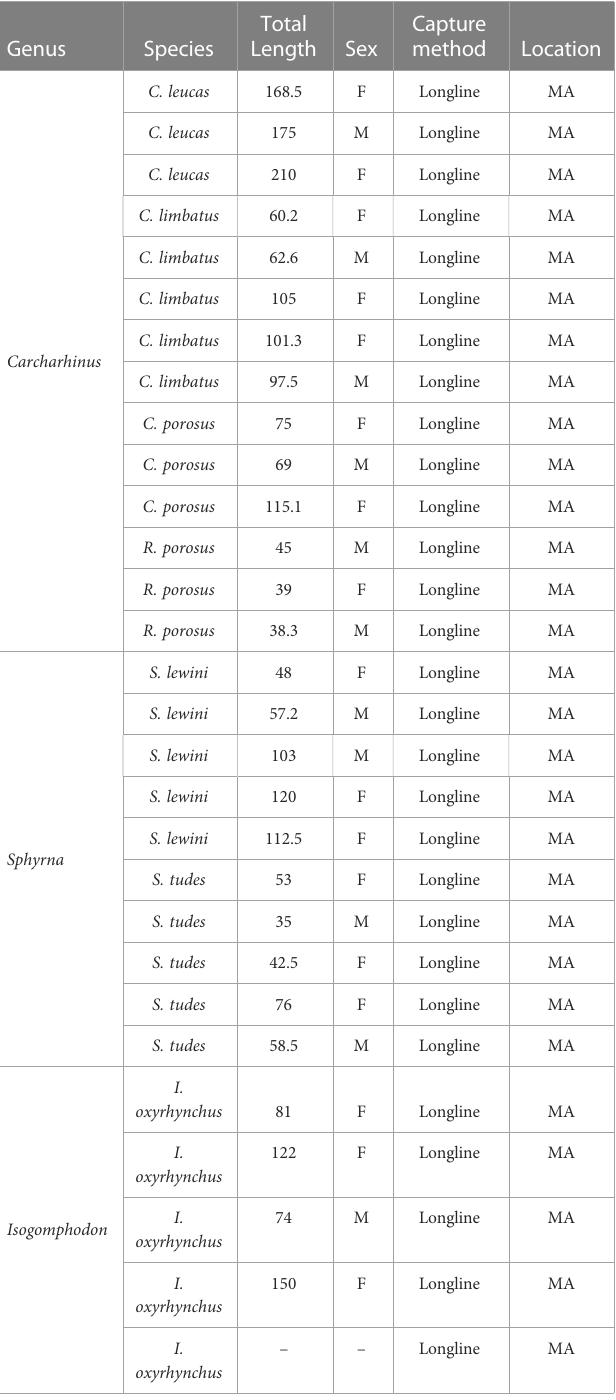
TABLE 1 Data on the shark specimens captured by artisanal fl eets in the state of Maranhão, Brazil, evaluated in the present study.